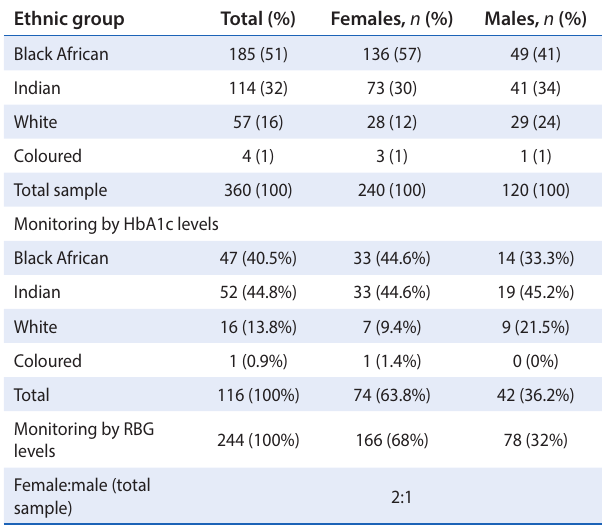
Table 1: Distribution of sample by ethnicity, gender, HbA1c and RBG levels Ethnic